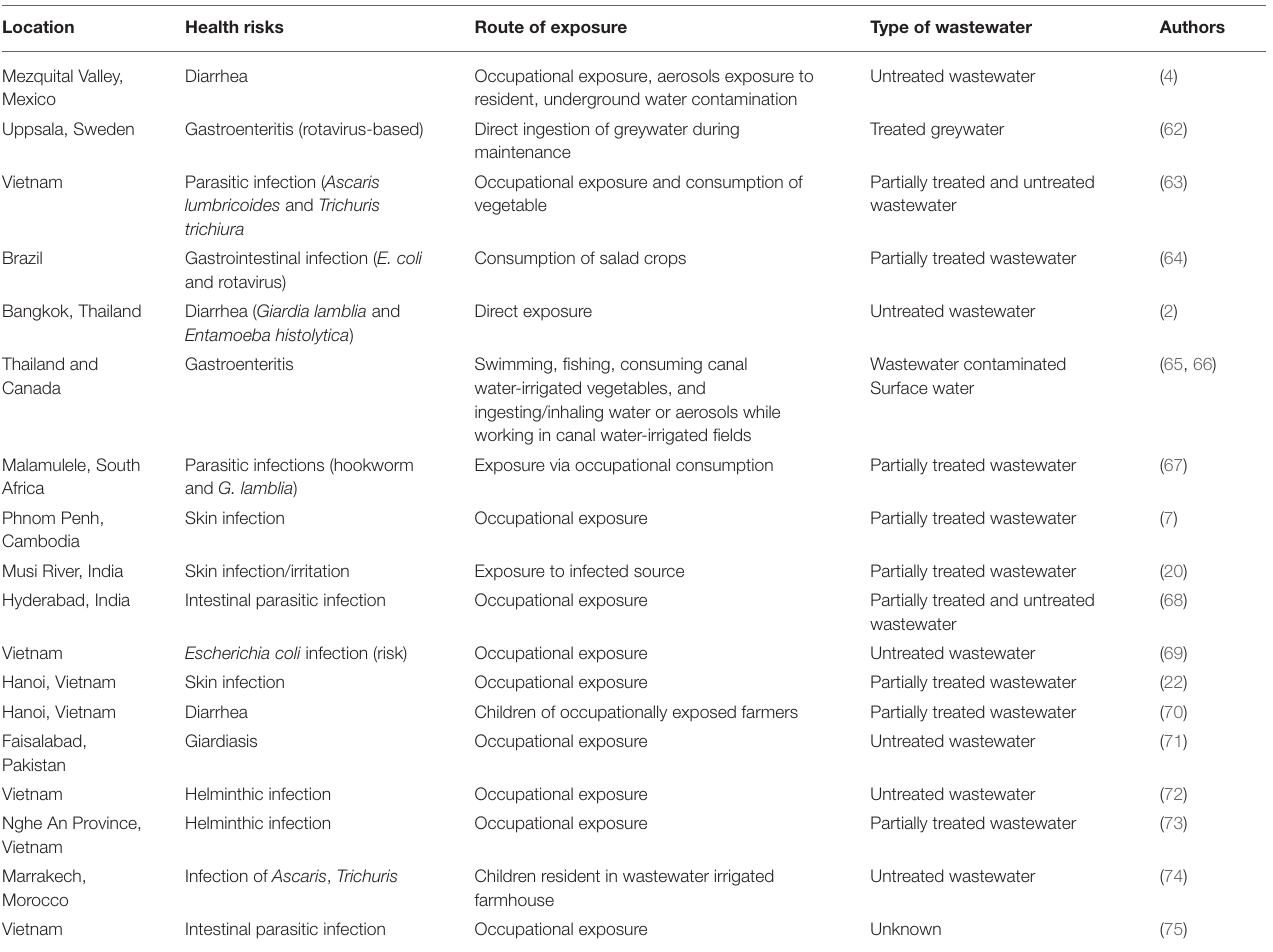
TABLE 2 | Exposure used in the determination of diseases associated with wastewater irrigation from selected literature.